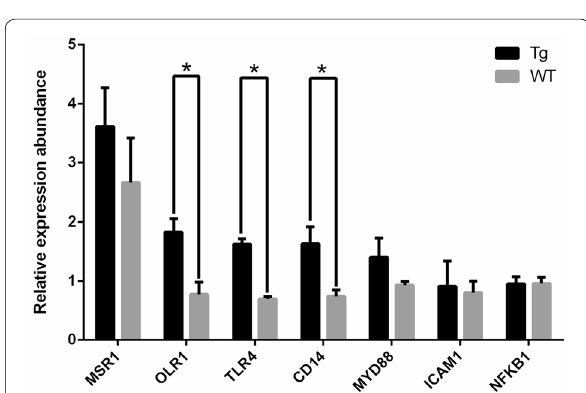
Fig. 6 Real-time PCR of internalization-associated genes. Symbol of “*” indicate significant differences ( p < 0.05) between the Tg and WT